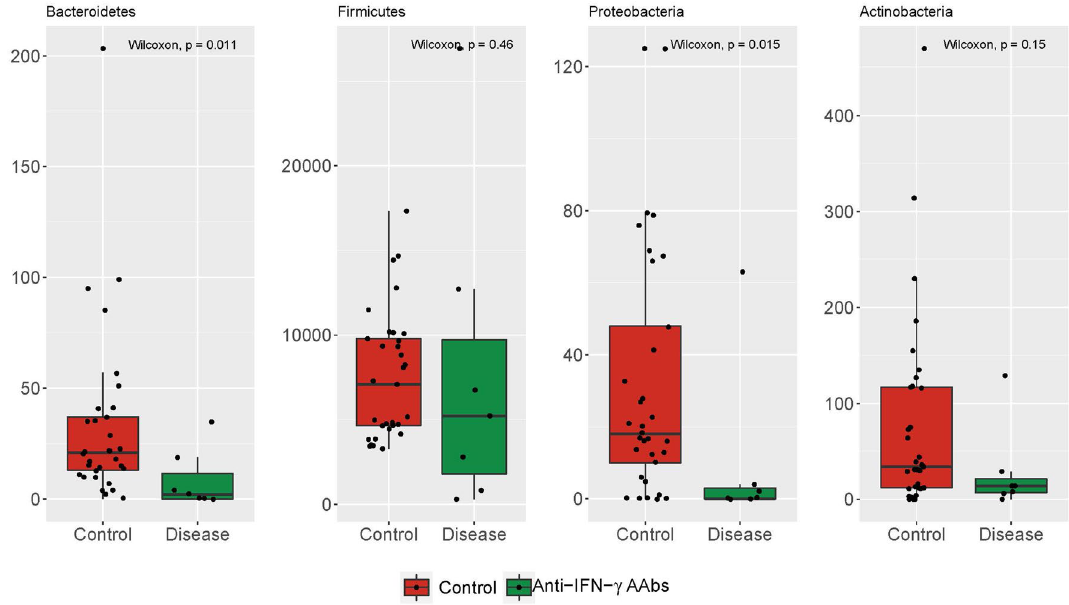
Figure 3. The relative abundances of the 4 major phyla of the fecal samples between Anti-IFN-γ AAbs and HC cohorts. Boxplots show the interquartile ranges and medium relative abundances. anti-IFN-γ AAbs anti- interferon-gamma autoantibodies, HC healthy